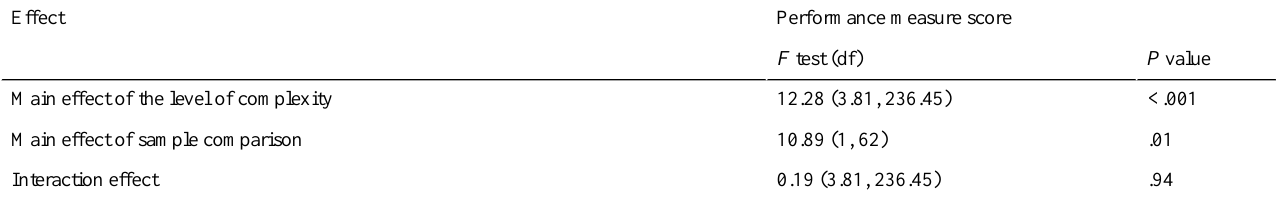
Table 6. Inferential statistics for research question 2.